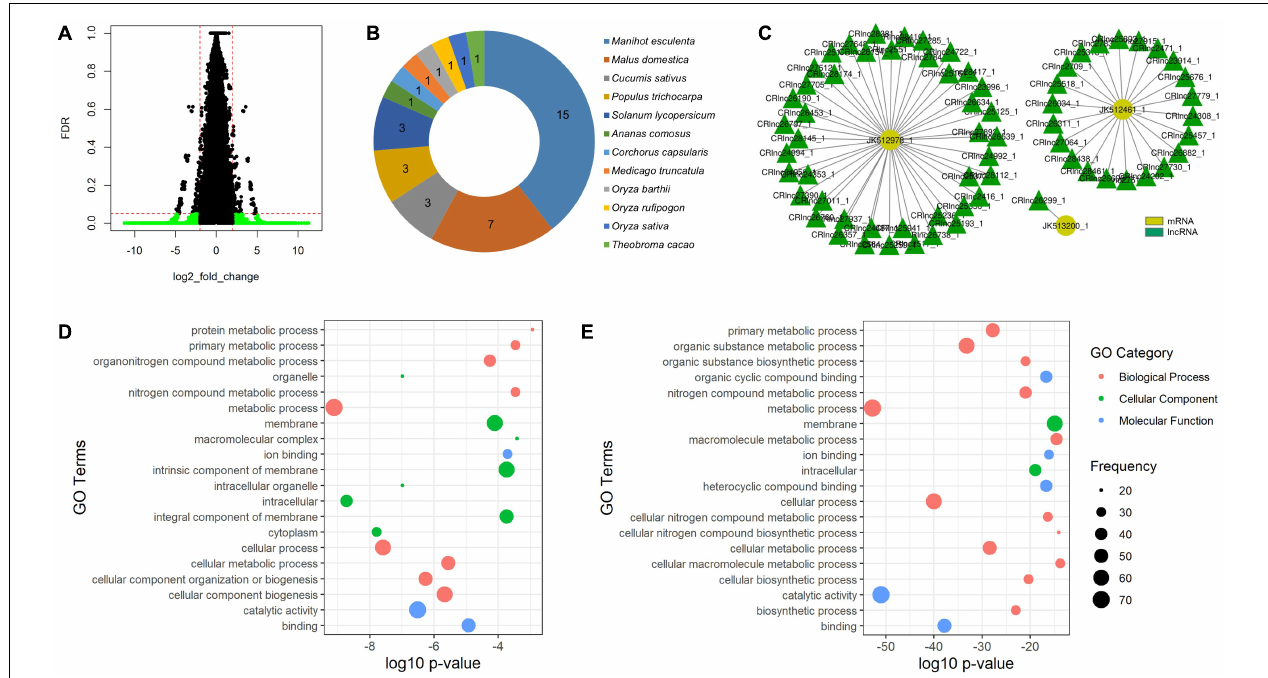
FIGURE 3 | Temperature-responsive lncRNAs of mango. (A) Volcano plot of cold-responsive lncRNAs of mango; green plots represent significantly expressed cold-responsive lncRNAs with false discovery rate (adjusted p -value) of less than 0.05 and log2 fold change of less than –2 or greater than 2; (B) conserved number of mango lncRNAs in different plant species; (C) interaction subnetwork between three low temperature-responsive proteins and cold-responsive lncRNAs of mango; (D) GO enrichment analysis of highly enriched genes targeted by heat-responsive lncRNAs; (E) GO enrichment analysis of highly enriched target genes of cold-responsive